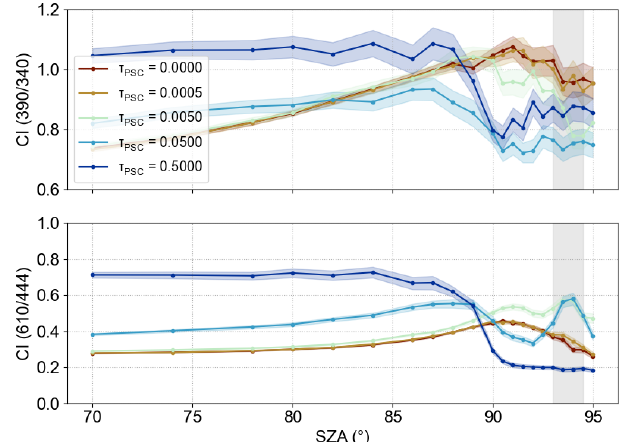
Figure 3. Simulation result (normalised CI) of different PSC layer heights h PSC ( τ PSC = 0 . 05) for horizontally extended clouds. The colour index (CI) is normalised to the result without PSC layer for better comparison.